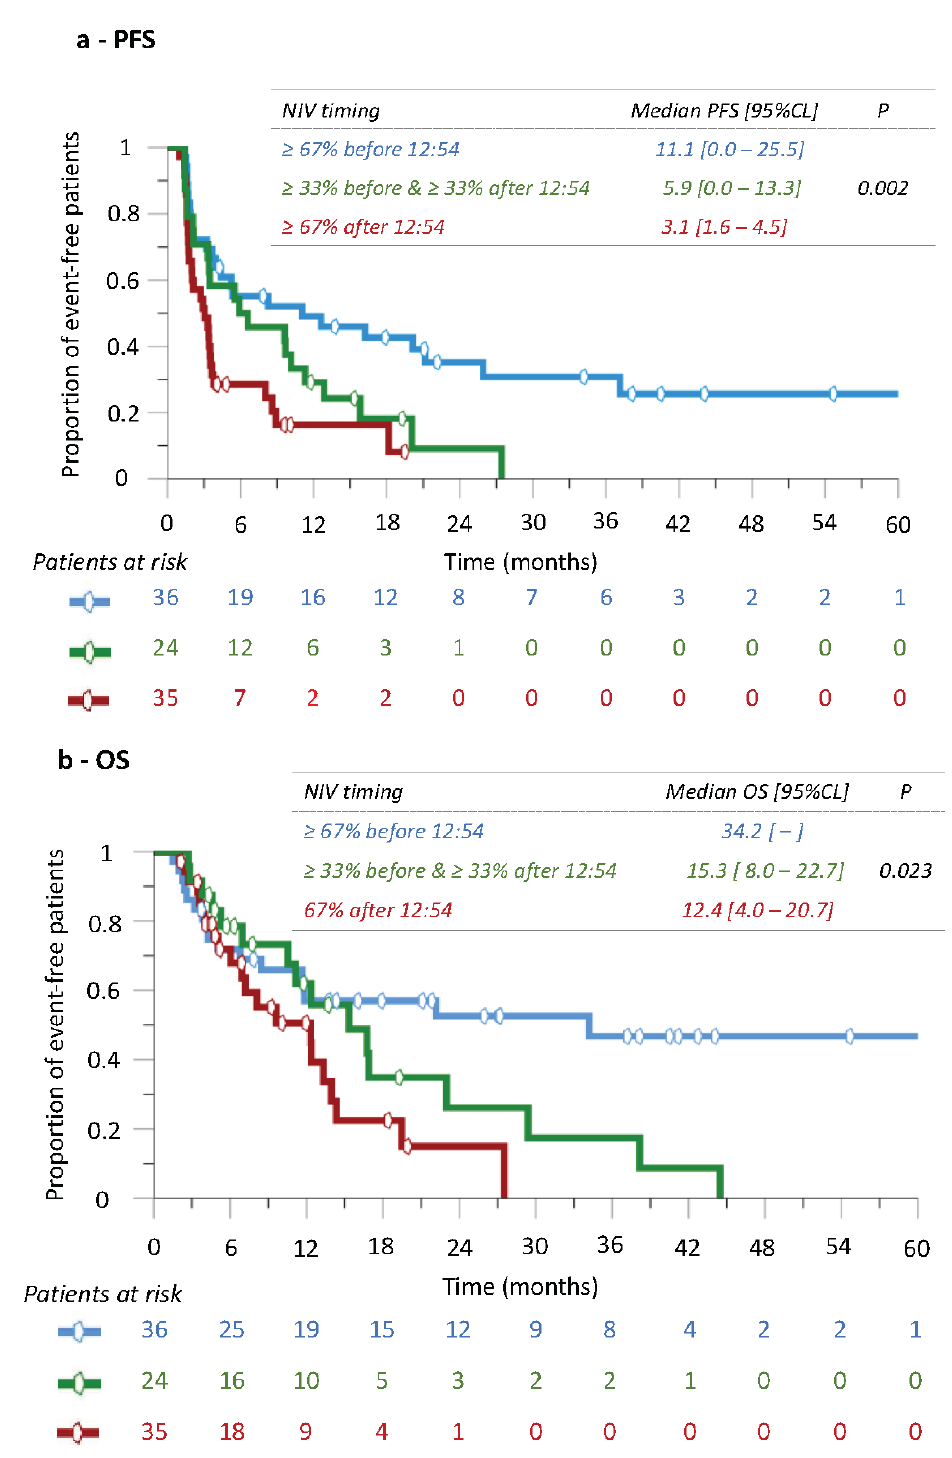
Figure 6. Kaplan–Meier curves of progression-free survival ( a ) and overall survival ( b ), according to three timing groups. Group 1 received at least 67% of the infusions before 12:54, Group 2 received at least 33% of the infusions before 12:54 and 33% of the infusions after 12:54, and Group 3 involved those patients receiving at least 67% of the infusions after